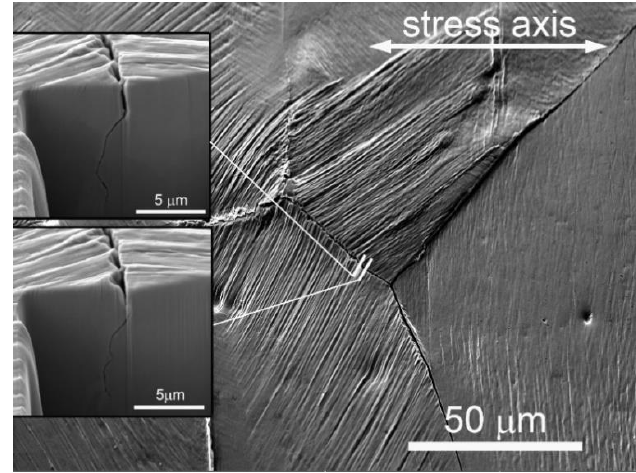
Figure 20. Surface of polycrystalline copper cycled with ε H = 4 × 10 −3 to fracture ( N f = 5600 cycles); several grain boundaries are cracked, and FIB cuts presented in the insets show the shape and the depth of grain boundary crack.